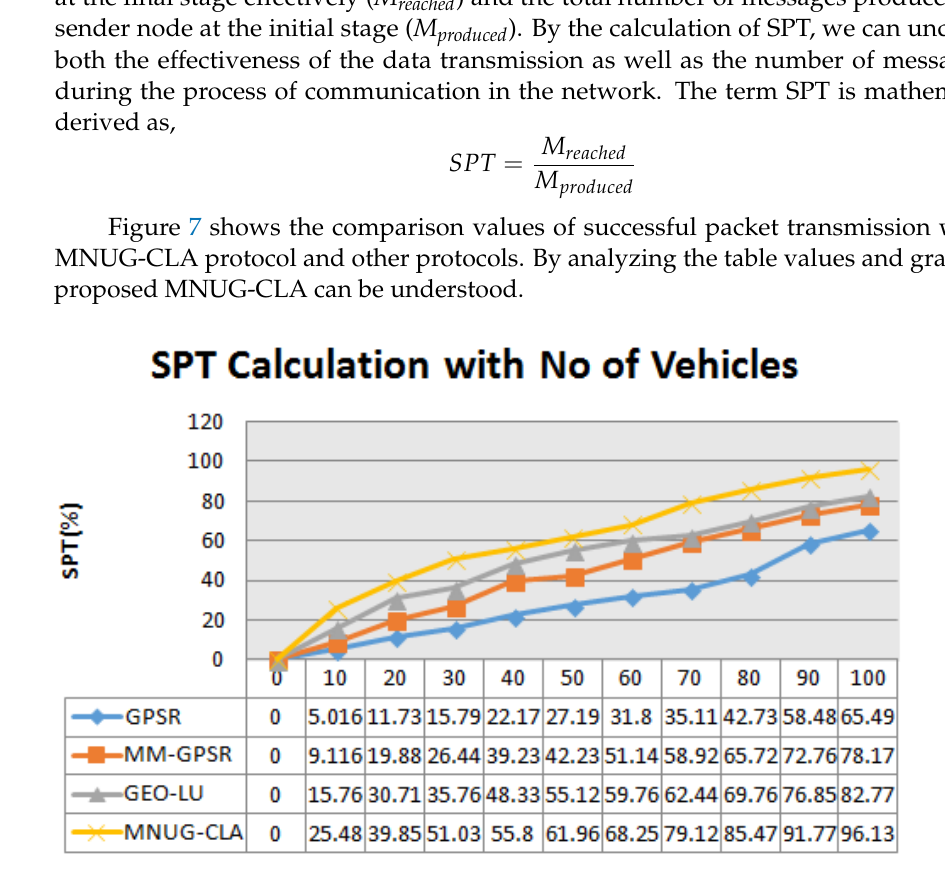
Figure 7. Successful Packet Transmission Calculation.